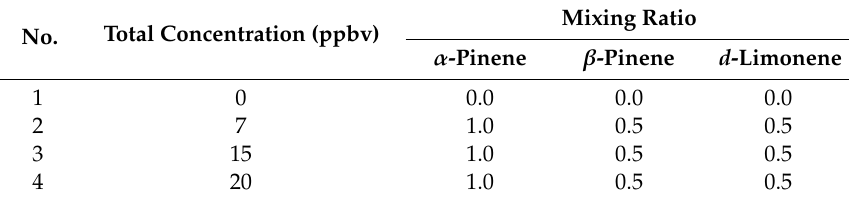
Table 3. Mixing ratios and concentrations of MTs for Exp 2.